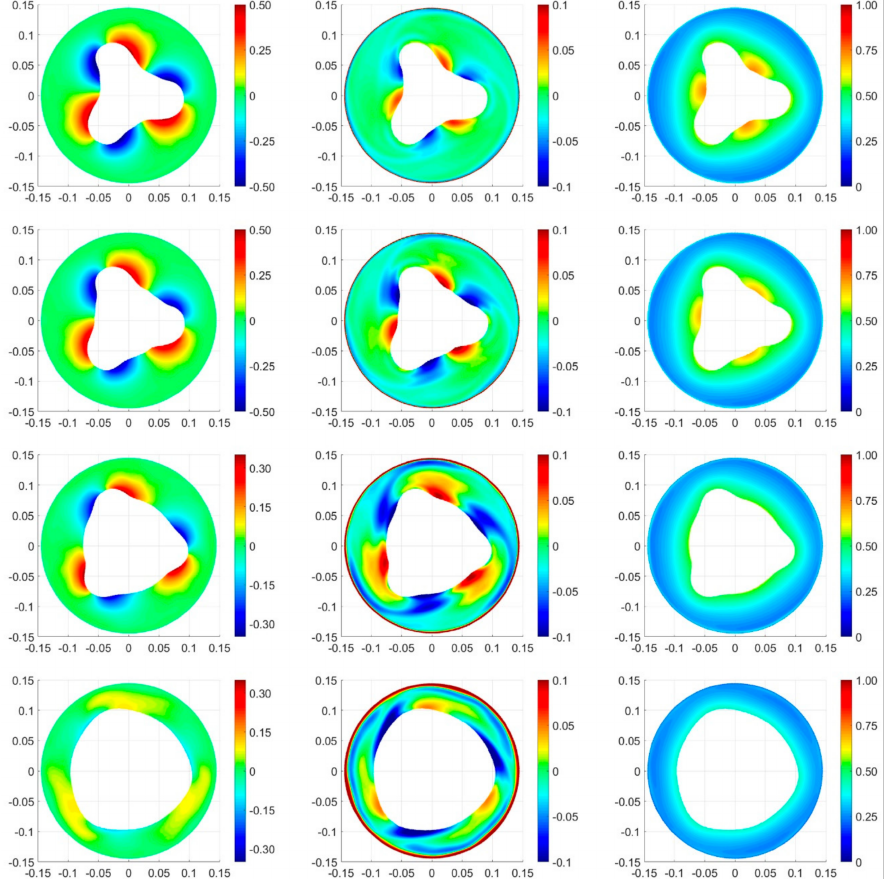
Figure 10. Top view contours of the radial, axial (both in m/s) and normalized tangential velocities at four heights (from top to bottom: 5, 10, 30 and 60 mm) above the 4.6 Hz rotating disk. Each contour is rotated to the contour of t = 0 s using maximum correlation between the shapes. Velocity values are averaged if the specific location was occupied by water more than 50% of the frames, otherwise white color is